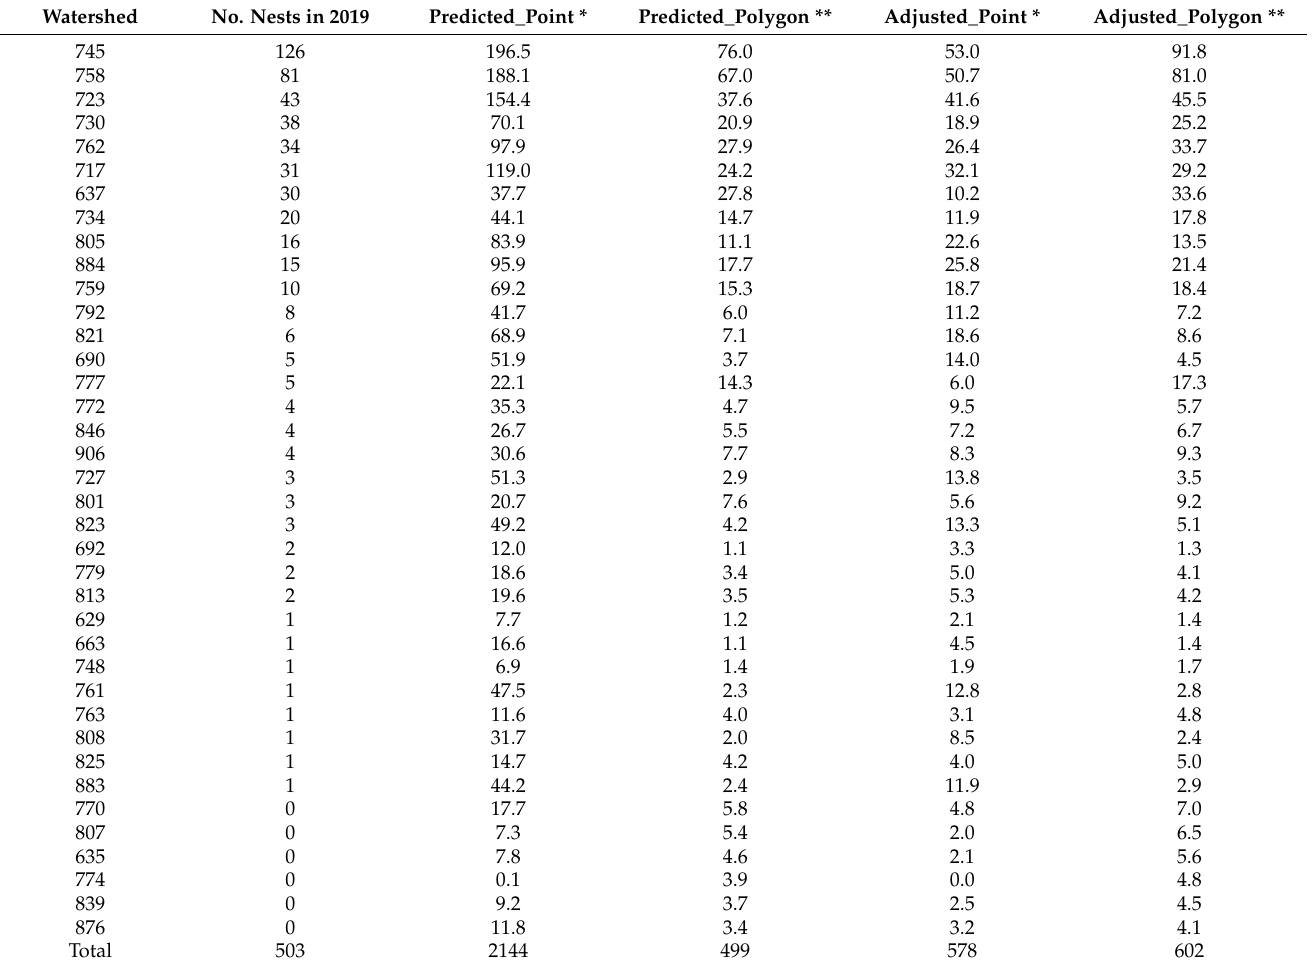
Table 4. The observed number of nests in each watershed, predicted number of nests and adjusted number of nests using occurrence-based method and watershed-based method,